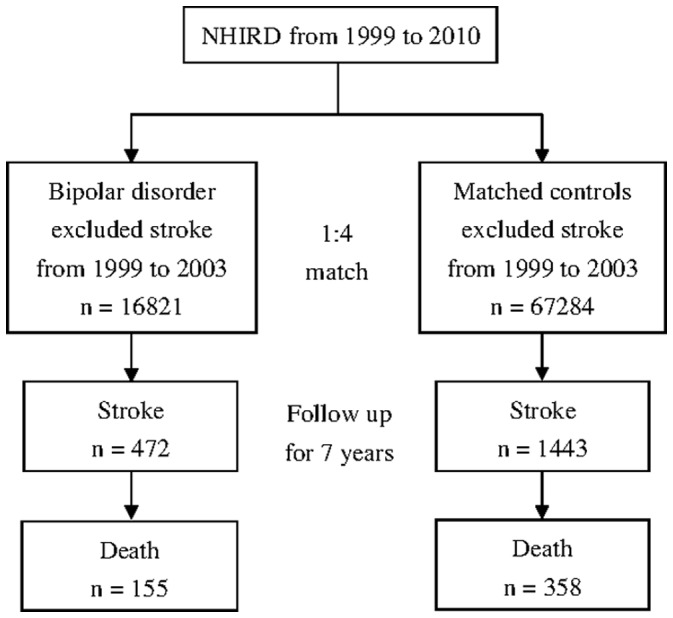
Sampling from the NHIRD.